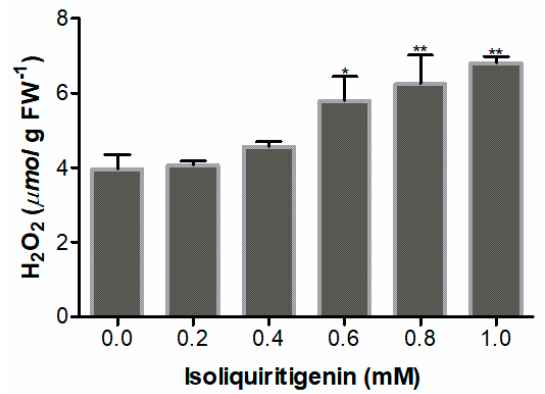
Figure 5. H 2 O 2 content in lettuce radicles after treatment with different concentrations of isoliquiritigenin. Data presented are the mean ± standard deviation of results from three independent experiments. N = 3. One asterisk * and two asterisks ** represent the significant difference between the isoliquiritigenin-treated lettuce radicle and the control at p < 0.05 and p < 0.01, respectively.